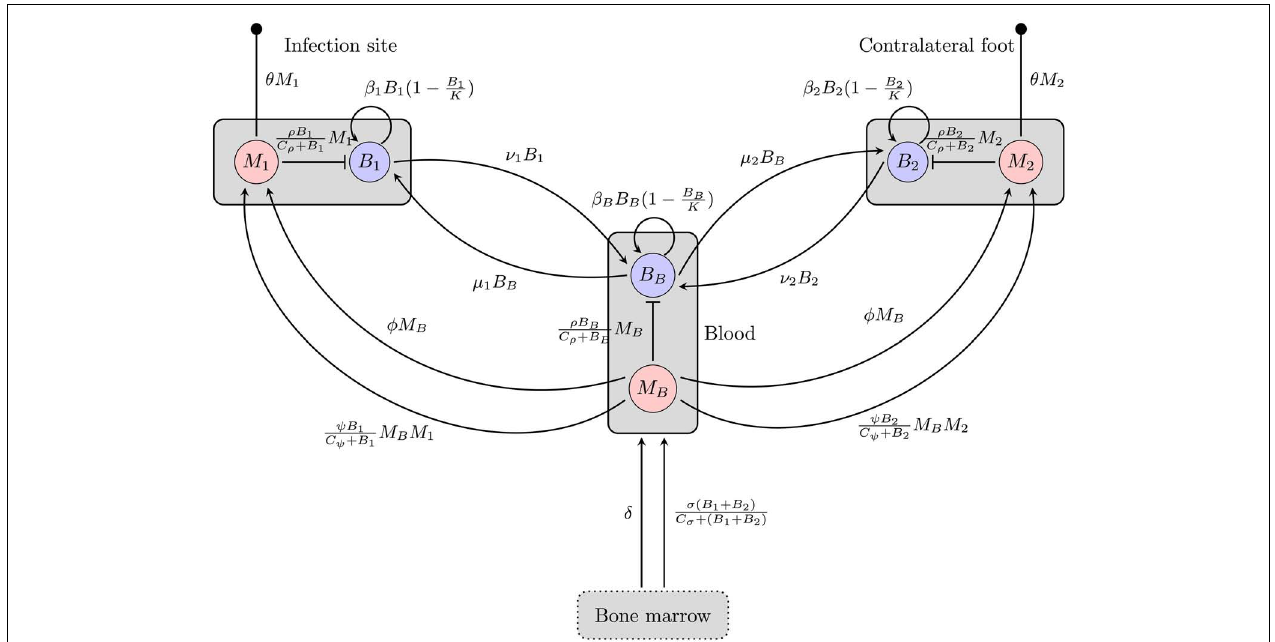
bacterial replication rates, K : carrying capacity for bacteria, ρ : phagocytosis rate, C ρ : bacterial concentration with half-maximal phagocytosis rate, δ : physiological phagocyte production rate, σ : phagocyte production in response to infection, C σ : bacterial concentration with half-maximal phagocyte production, φ : physiological phagocyte migration to tissue, ψ : phagocyte recruitment in response to infection, C ψ : bacterial concentration with half-maximal phagocyte recruitment, θ : phagocyte death rate.